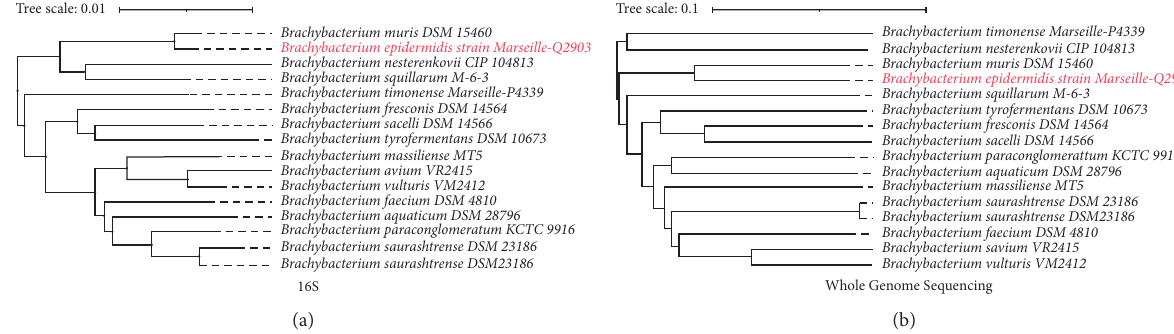
Figure 1: (a) 16s rRNA-based phylogenetic tree. (b) Whole genome-based phylogenetic tree highlighting the position of B . epidermidis sp nov. strain Marseille-Q2903 T , relative to other closely related bacterial species.